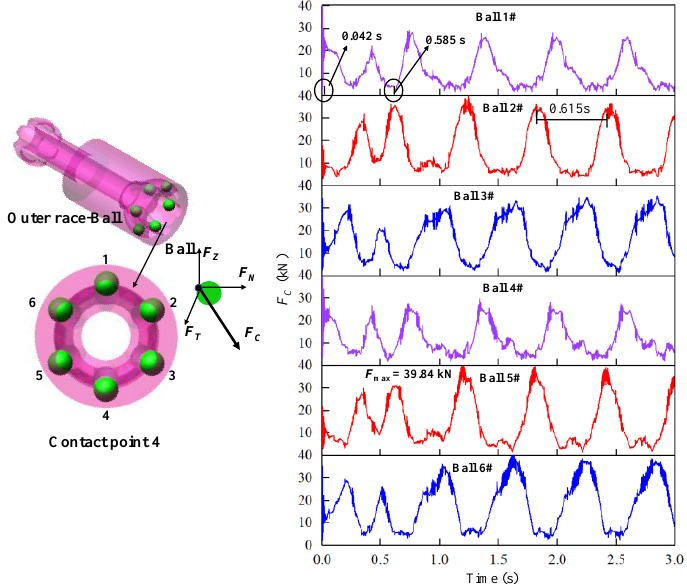
Figure 11. The variation of contact force between outer race and ball keys.